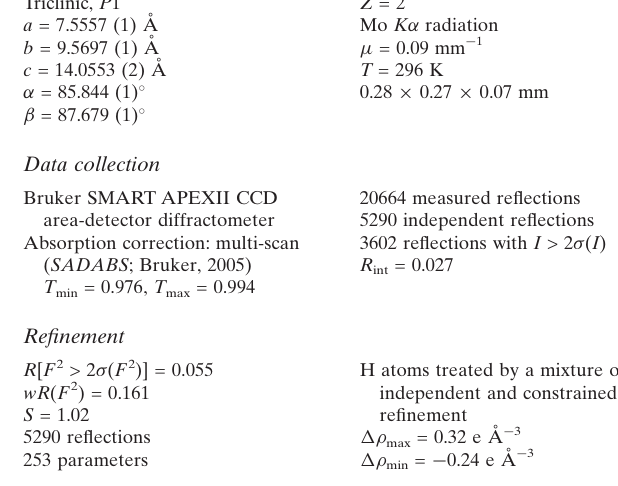
20664 measured reflections 5290 independent reflections 3602 reflections with I > 2 (cid:2) ( I ) R int = 0.027